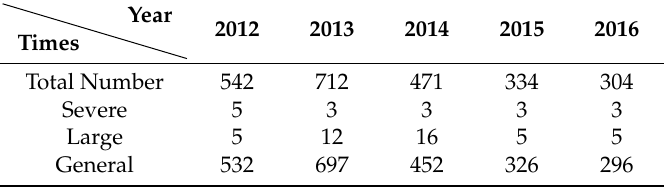
Table 1. The number of the environmental emergencies occurred per year from 2012 to 2016,